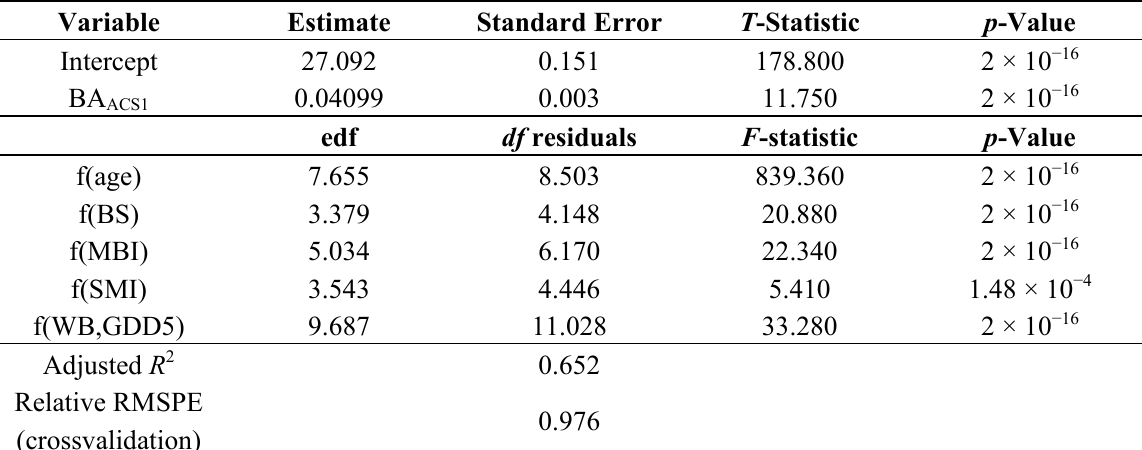
Table 5. Detailed summary of the main model